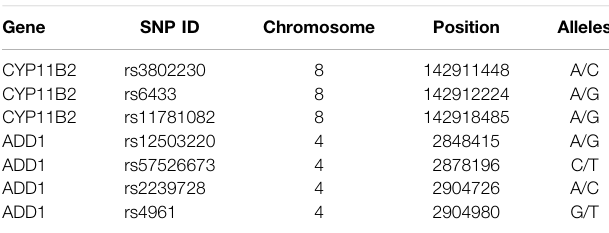
TABLE 3 | Basic information of seven